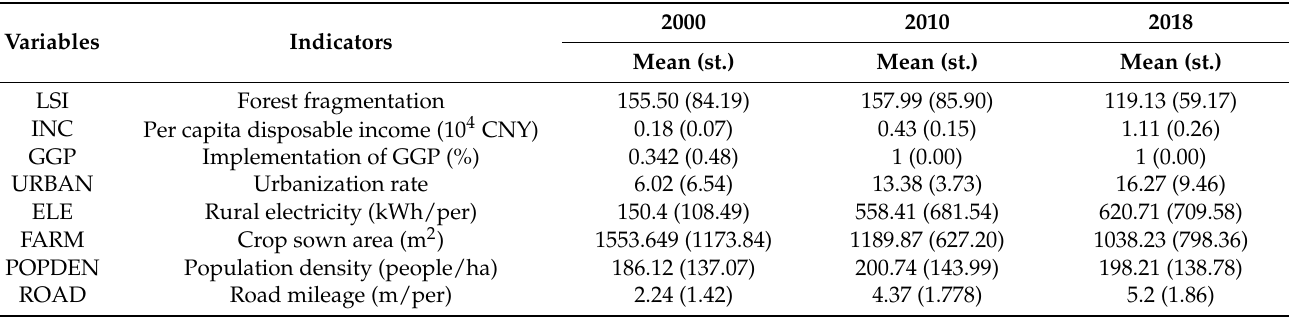
Table 2. Descriptive statistics of the variables.